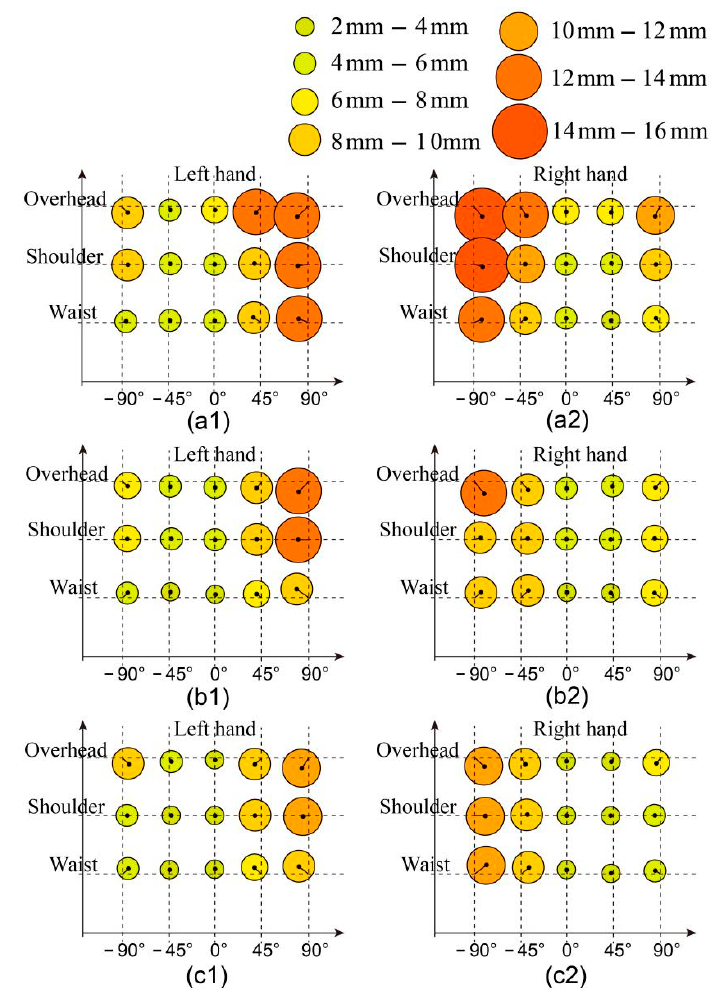
Figure 8. End-point scatters at different positions and operational distances: ( a1 ) and ( a2 ) are end-point scatters at a stretched arm posture; ( b1 ) and ( b2 ) are end-point scatters at a half-bent arm posture; ( c1 ) and ( c2 ) are end-point scatters at a wholly-bent arm posture.